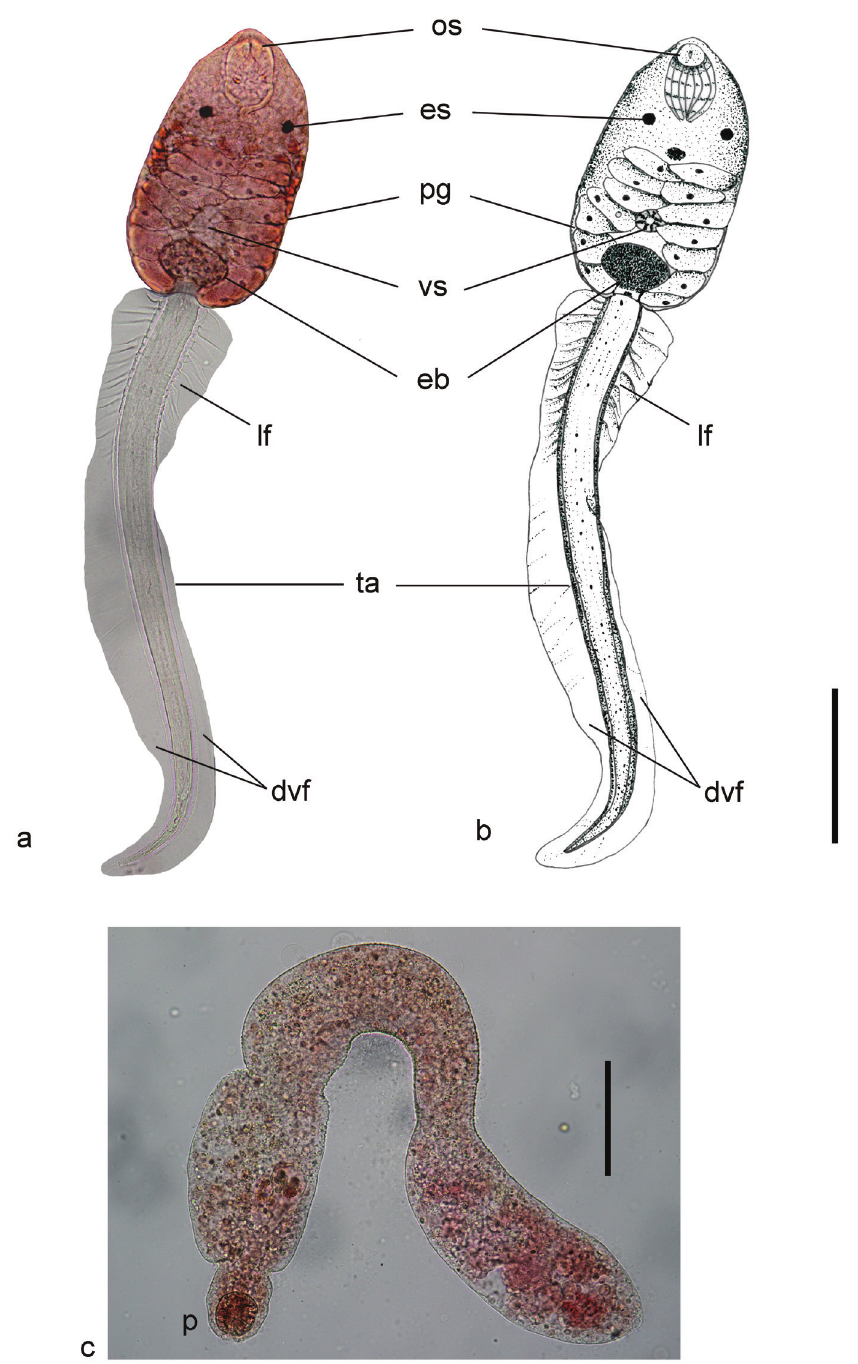
Figure 8. Haplorchis pumilio (Looss, 1896). a . specimen stained with 0.5% neutral red. b . drawing of cercaria. c . redia stained with 0.5% neutral red. Abbreviations – dvf: dorsoventral finfold; eb: excretory bladder; es: eyespot; lf: lateral finfold; os: oral sucker; p: pharynx; pg: penetration gland; ta – tail; vs: ventral sucker. Scale bars: 50